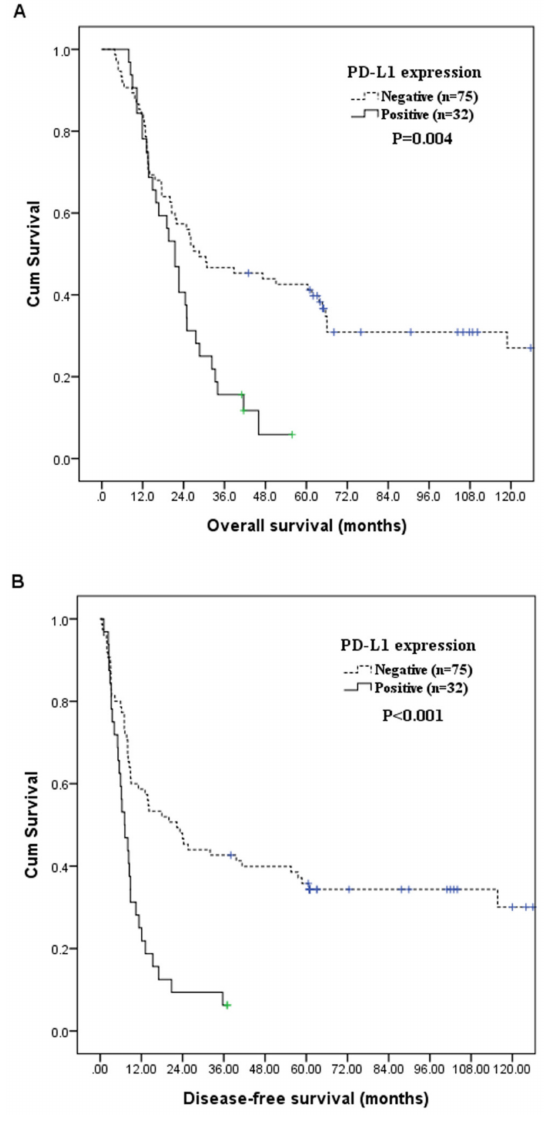
Figure 2. ( A ) Overall survival according to PD-L1 expression. ( B ) Disease-free survival according to PD-L1 expression. PD-L1, programmed death-ligand